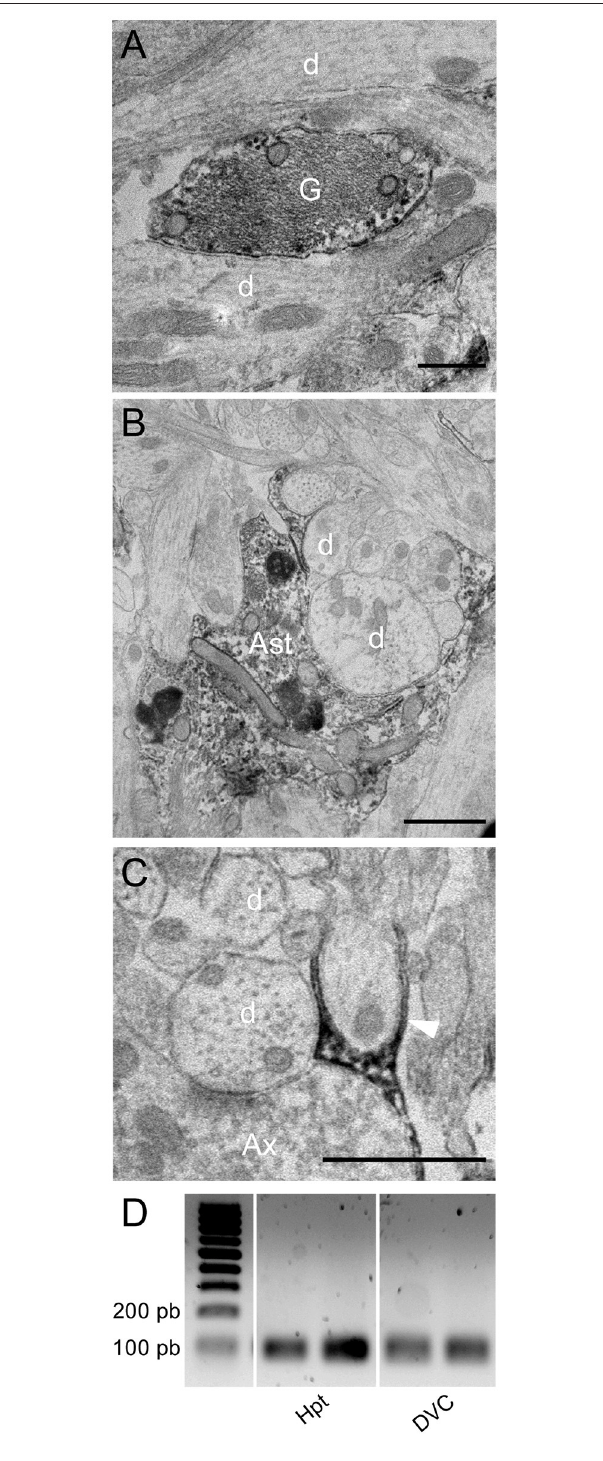
FIGURE 5 | Immunoelectron microscopy of ODN. (A,B) Electron micrographs taken from the subpostremal nucleus tractus solitarius (NTS) illustrating the ODN immunostaining in protoplasmic astrocytes. Note that ODN positive processes are sometimes strongly associated with neuronal elements (B) . (C) Electron micrograph originating from NTS/area postrema border showed a